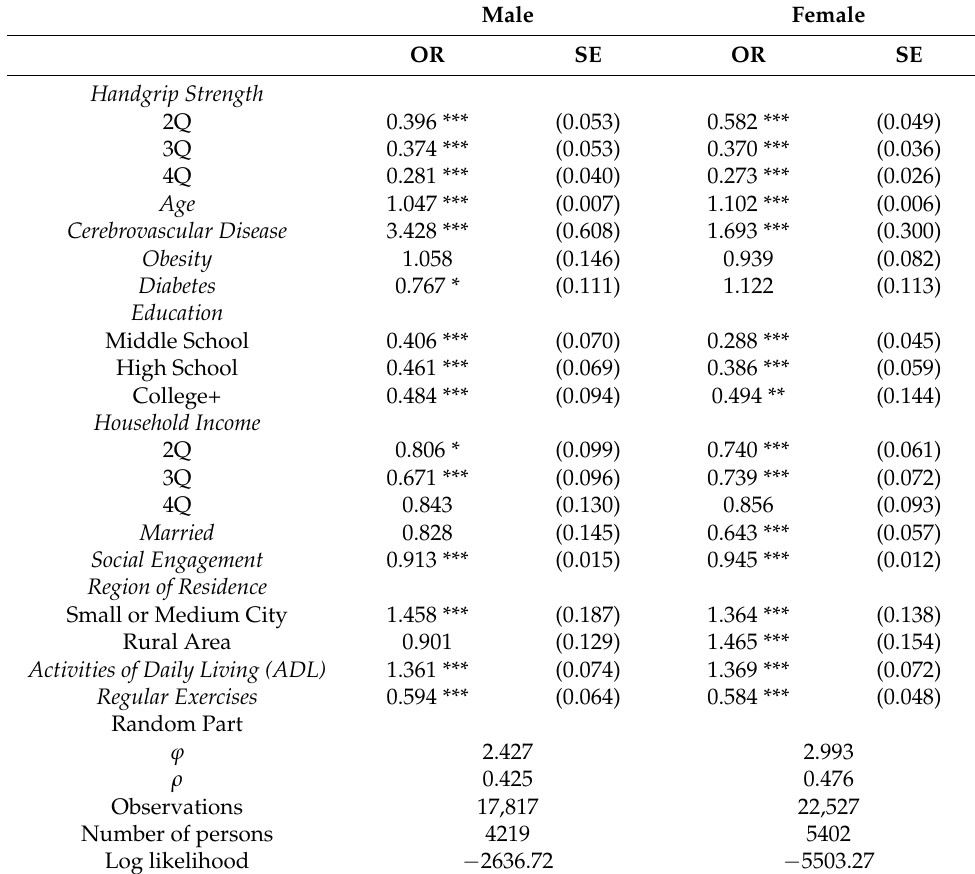
Table 2. Parameters and Standard Errors of the Random-Intercept Logistic Regression of Cognitive Impairment: Korean Longitudinal Study of Aging